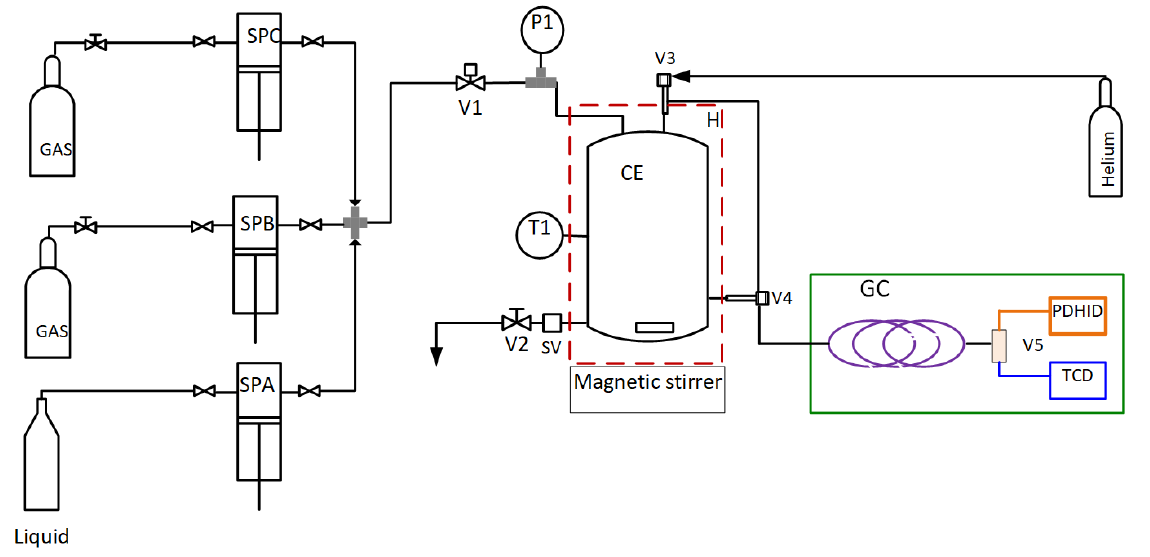
Figure 1. Schematic of the analytic-phase equilibrium apparatus: SPA, SPB and SPC syringe pumps. V1, a pneumatically operated valve; V2, needle valve; V3 and V4, Rolsi sampling valves; SV, rupture-disc pressure relief; CE, equilibrium cell; H, aluminium heat jacket; T1, temperature sensor; P1 pressure transducer; GC, gas chromatograph; V5, Deans Switching valve; thermal conductivity detector (TCD) and pulse-discharge helium ionization detector (PDHID).